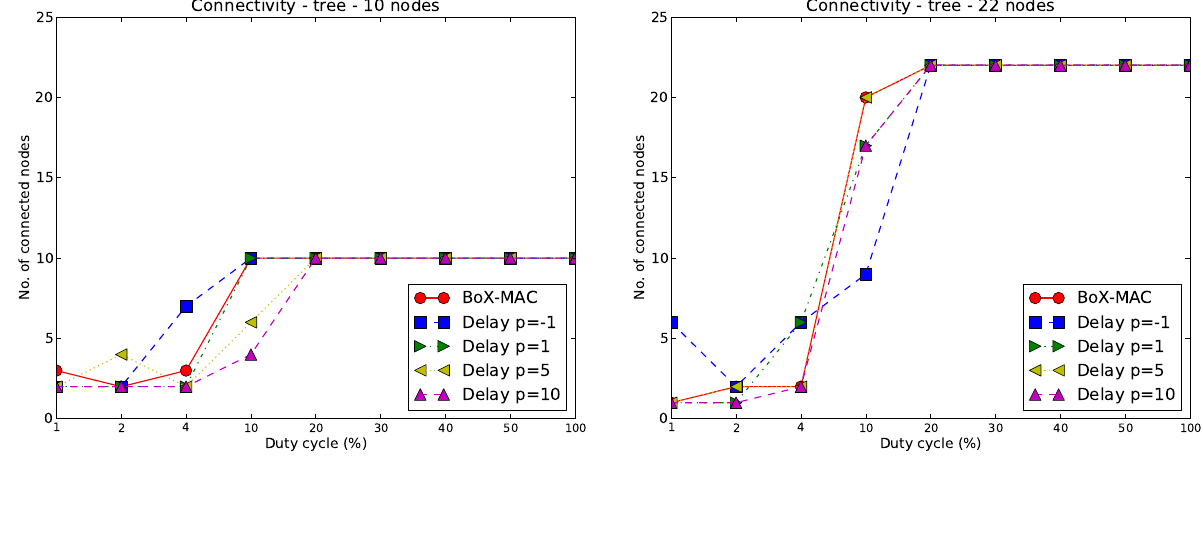
Figure 8. Connectivity of BoX-MAC and CLAC in 10-node (left) and 22-node (right) tree